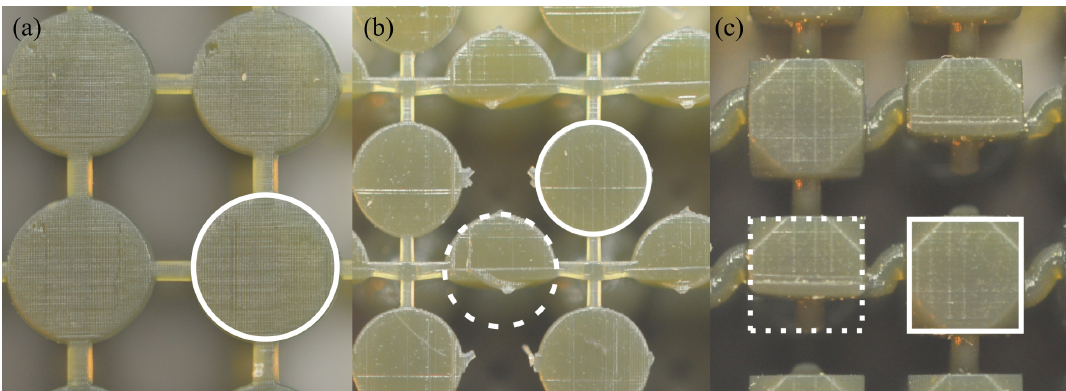
Figure 5. Comparison of ( a ) vertically supported mass to examples of printing errors for ( b ) incomplete horizontally connected balls corresponding to design Figure 1d, and ( c ) missing sections of cubic masses due to insufficient support beams.